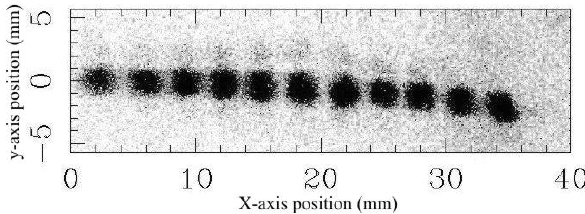
Fig. 8 . Image sequence showing the shift in focus position across the imaging plane produced as the optic is tilted through an angle of 22.3° in 2.23° steps. The distance between adjacent spots is 2.89 ± 0.08 mm. The curved path followed by the spots may be due to local deviations from the spherical figure, and hence correct slump radius, of the MCP (see Fig. 5).